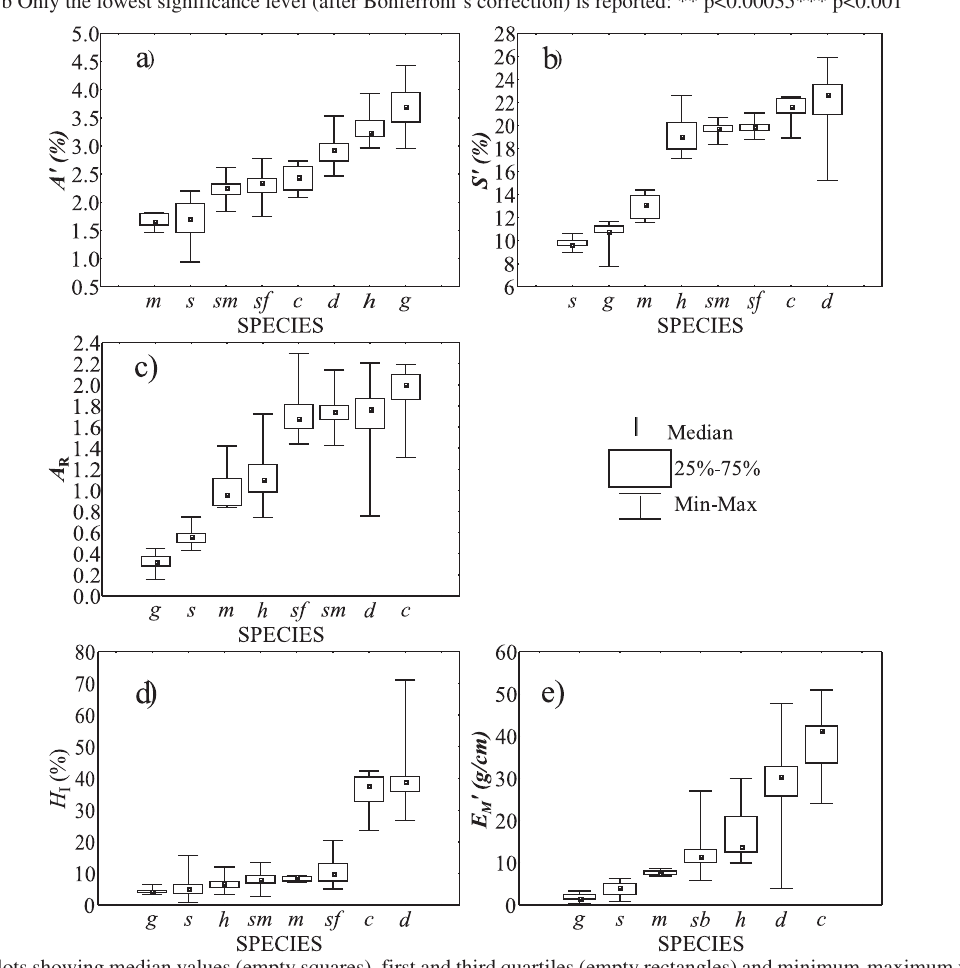
Table 6. – results of Kruskal-Wallis anoVa and mann-Whitney U test corrected for multiple comparison for tail aspect ratio ( A tosomatic index ( H ), body size-standardised caudal area ( A’ ), span ( S’ ) and muscular–skeletal amount per unit length ( E i melastomus ( g ), Sciliorhinus canicula ( s ), Mustelus asterias ( m ), Heptranchias perlo ( h ), Squalus blainvillei ( sb ; sbf : females; sbm : males), Dalatias licha ( d ) and Centrophorus uyato ( c ). in the bonferroni multiple comparison the underlined species are not significantly different ( P >0·00178). Kruskal-Wallis anoVa d.f.